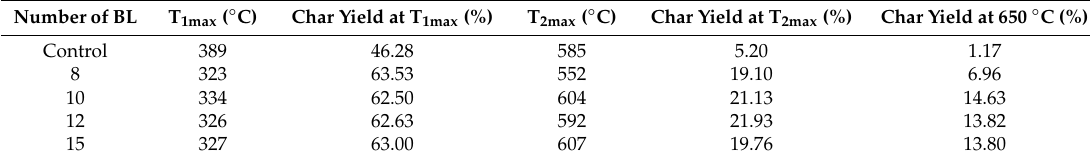
Table 4. Summary of thermogravimetric analysis of treated and untreated cotton.